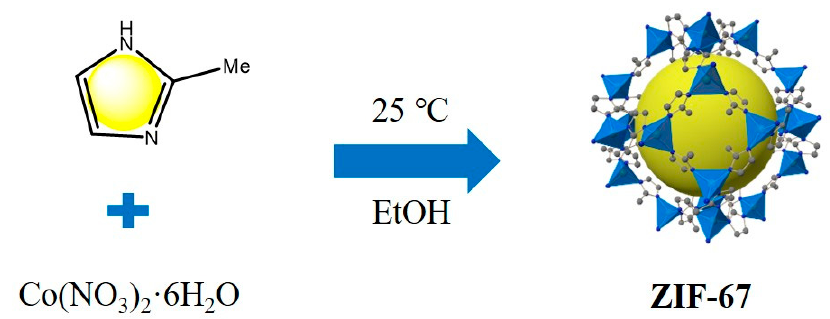
4 of 15 Figure 2. A structure diagram of ZIF-67-based EMOFs. 2. Results and Discussion